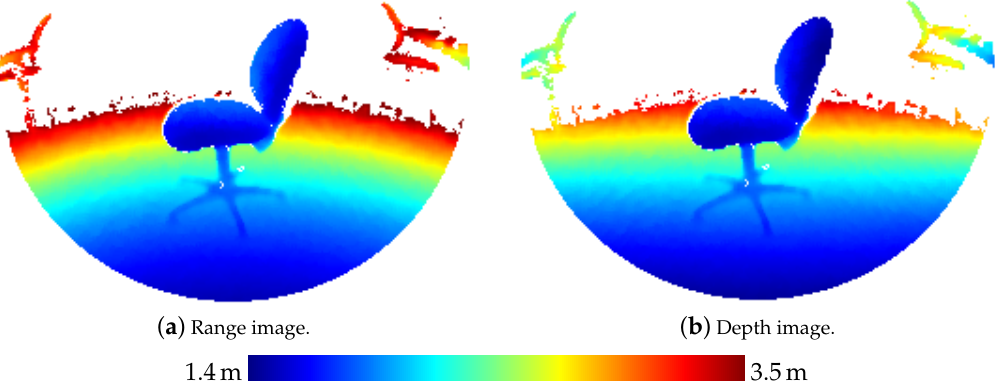
Figure 4. Range image and depth image corresponding to the long throw intensity image shown in Figure